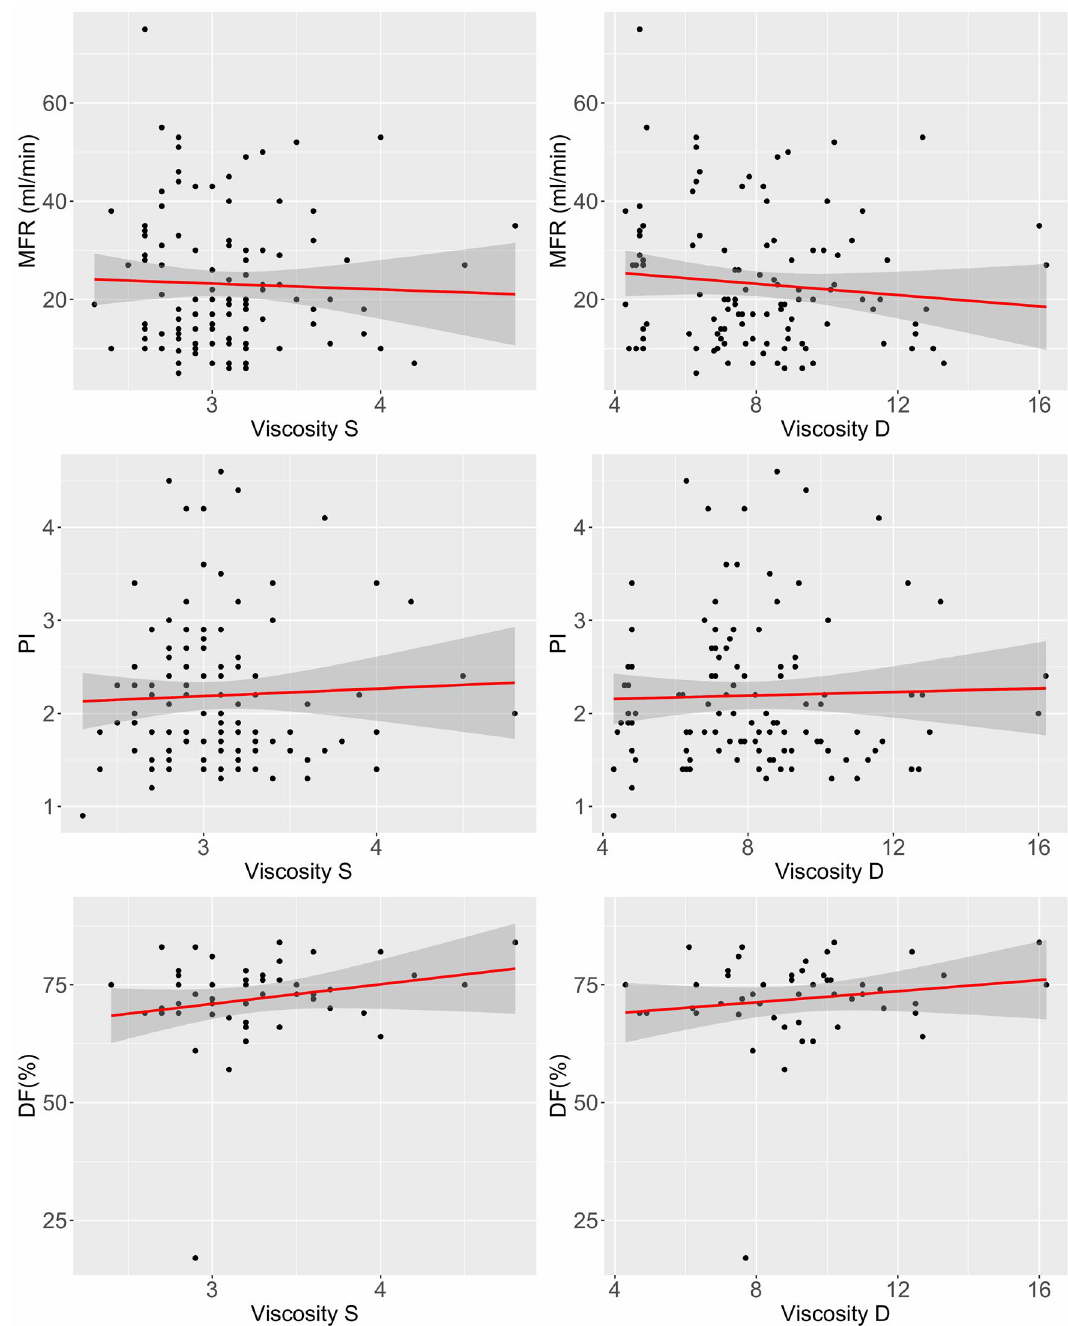
Figure 4. Scatter plot showing the correlation between the three parameters of TTFM and viscosity. MFR mean flow rate, PI pulsatility index, DF diastolic filling, TTFM transit-time flow measurement. Viscosity S, systolic blood viscosity; Viscosity D, diastolic blood